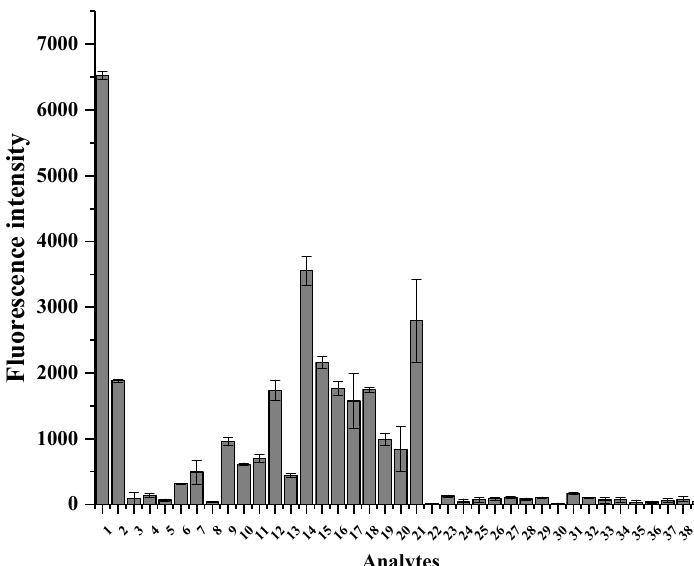
Figure 5. Fluorescence intensity of FPN1 (300 mg/L) upon addition of various analytes (15 mg/L for each, 1, acetaldehyde; 2, acetal; 3, furfural; 4, 5-HMF; 5, acetoin; 6, 2,3-butanedione; 7, 2,3-pentanedione; 8, 2.3-hexanedione; 9, pruvate; 10, propanone; 11, hydroxypropanone; 12, α -ketoglntaric acid; 13, methylglyoxal; 14, propionaldehyde; 15, butyraldehyde; 16, isobutyraldehyde; 17, isovaleraldehyde; 18, caproaldehyde; 19, nonanal; 20, phenylacetaldehyde; 21, glyoxal; 22, Asn; 23, Gln; 24, ethanol; 25, 1-propanol; 26, 1-butanol; 27, isobutanol; 28, isoamyl alcohol; 29, phenethyl alcohol; 30, 3-methylbutanol; 31, acetic acid; 32, lactic acid; 33, ethyl acetate; 34, isopentyl acetate; 35, caproic acid; 36, ethyl caproate; 37, ethyl lactate; 38, MES; 39, TMP. The test was performed in triplicate.